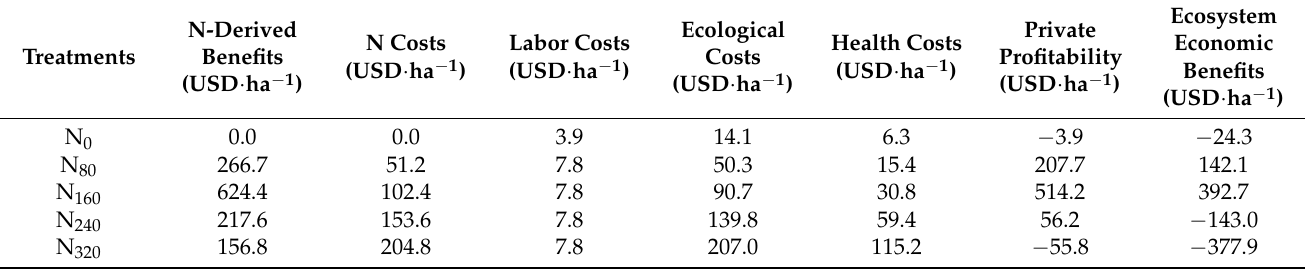
Table 3. Mean costs and benefits of forage sorghum production under different N treatments across